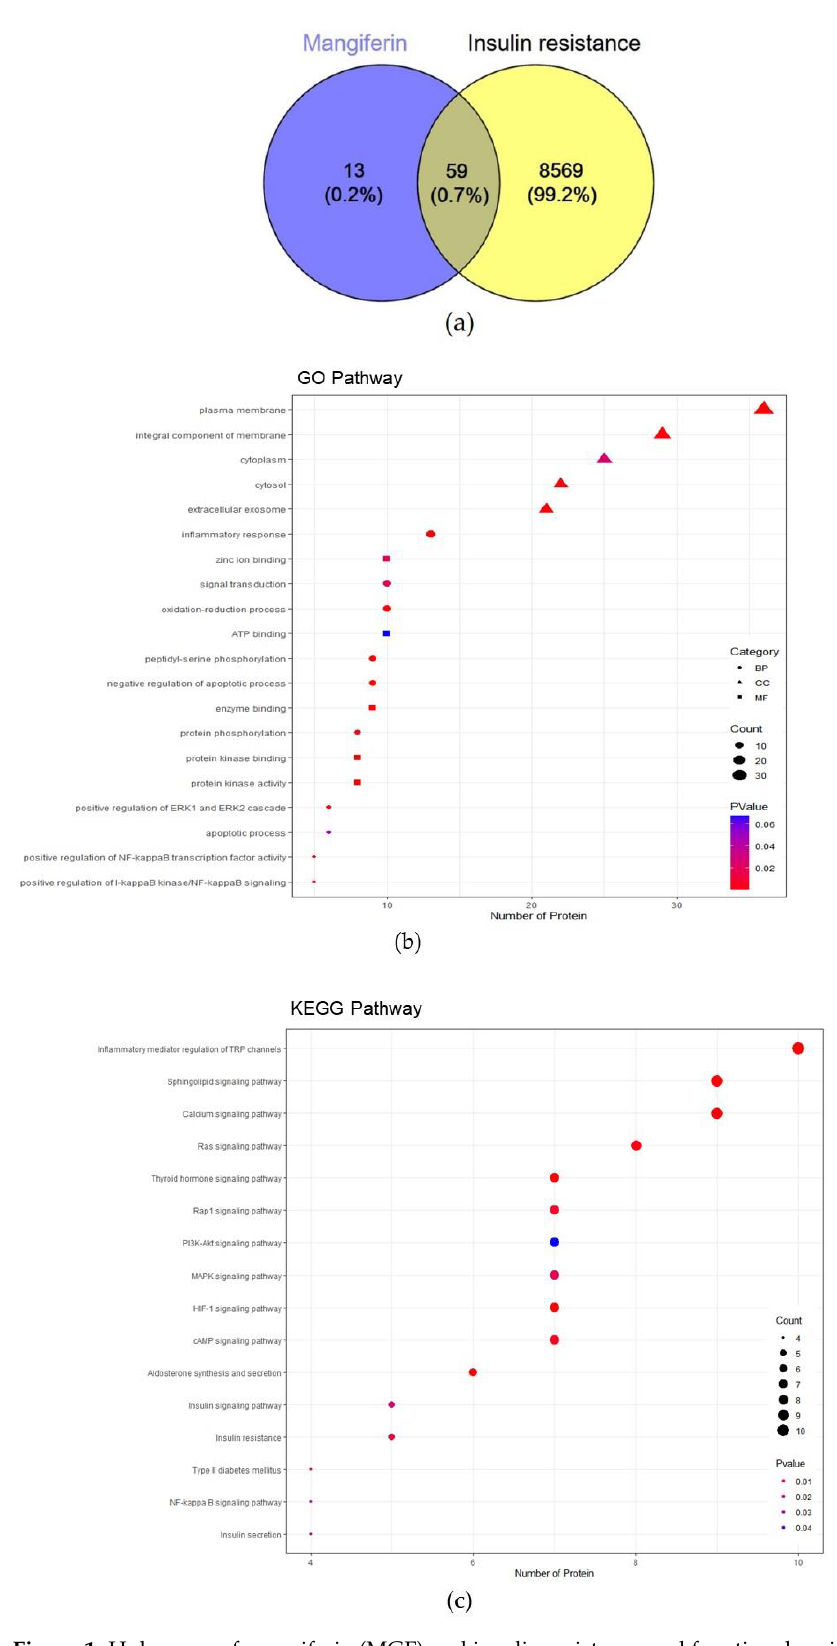
Figure 1. Hub genes of mangiferin (MGF) and insulin resistance and functional enrichment analysis. ( a ) The 59 overlapping genes between MGF and insulin resistance. ( b ) GO enrichment analysis. ( c ) KEGG pathway enrichment analysis. GO , gene ontology; KEGG, Kyoto Encyclopedia of Genes and Genomes.